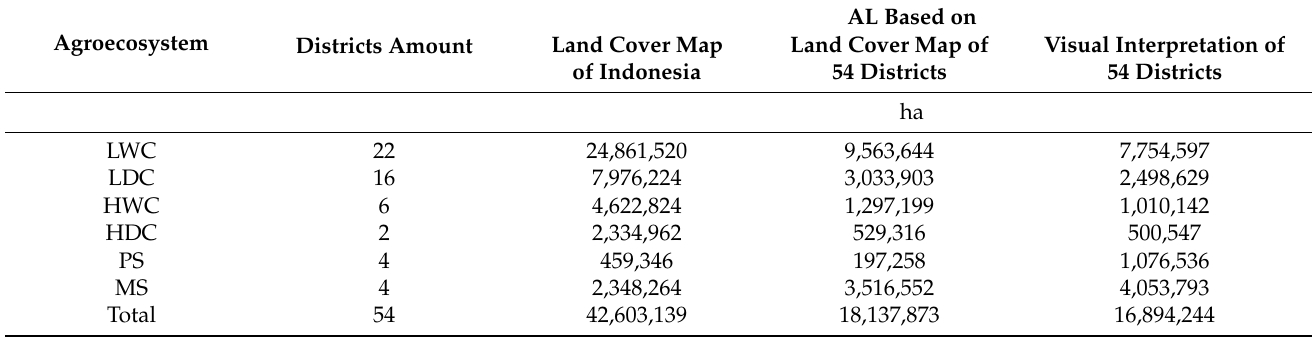
Table 4. The AL at the national and district levels for six